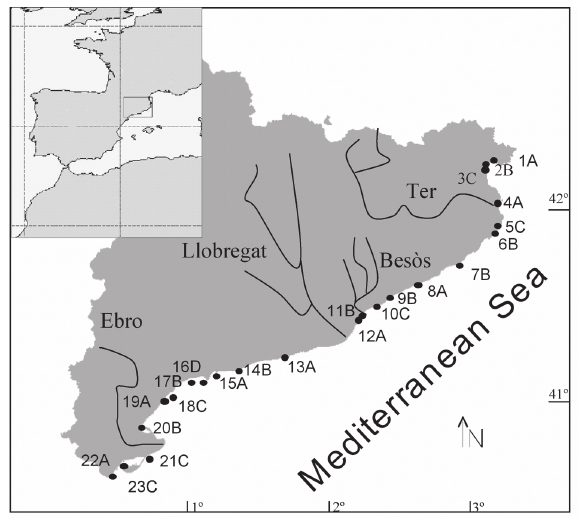
Fig . 1. – geographic location of catalonia, Spain, and the specific locations sampled during the years 2005 and 2006. Station’s name. 1 roses; 2 empuriabrava; 3 muga; 4 estartit; 5 Fosca; 6 palamós; 7 Blanes; 8 arenys; 9 premià; 10 parc del litoral; 11 olímpic; 12 Barcelona; 13 vilanova; 14 torredembarra; 15 tarragona; 16 La pineda; 17 cambrils; 18 alguer; 19 ametlla; 20 ampolla; 21 eucal- iptus; 22 St. carles; 23 parc de garbí. Sample frequency codes: a Weekly from may-Sept., bimonthly rest of the year harbours, B Bi- monthly may-Sept., monthly rest of the year harbours, c Bimonthly may-Sept., monthly rest of the year beaches, d extra